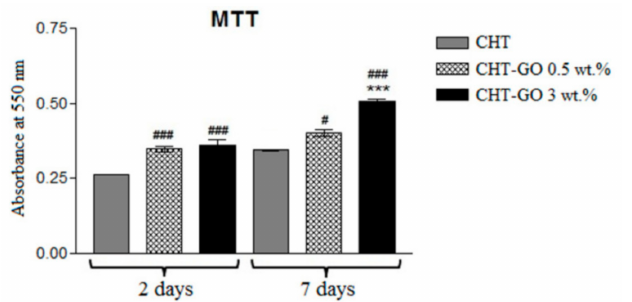
Figure 4. Quantification of MC3T3-E1 preosteoblast metabolic activity in contact with chitosan and chitosan/GO films. Statistical significance: # p < 0.05 (CHT/GO 0.5 wt% 7 days vs. CHT 7 days); ### p < 0.001 [(CHT/GO 0.5 wt% 2 days vs. CHT 2 days); (CHT/GO 3 wt% 2 days vs. CHT 2 days); (CHT/GO 3 wt% 7 days vs. CHT 7 days)]; *** p < 0.001 (CHT/GO 3 wt% 7 days vs. CHT/GO 0.5 wt% 7 days)